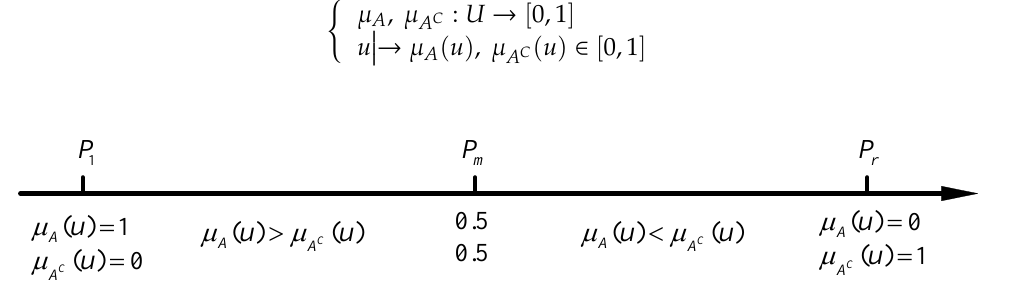
Figure 1. Conversion relationship between µ A ( u ) and µ A C ( u ) .